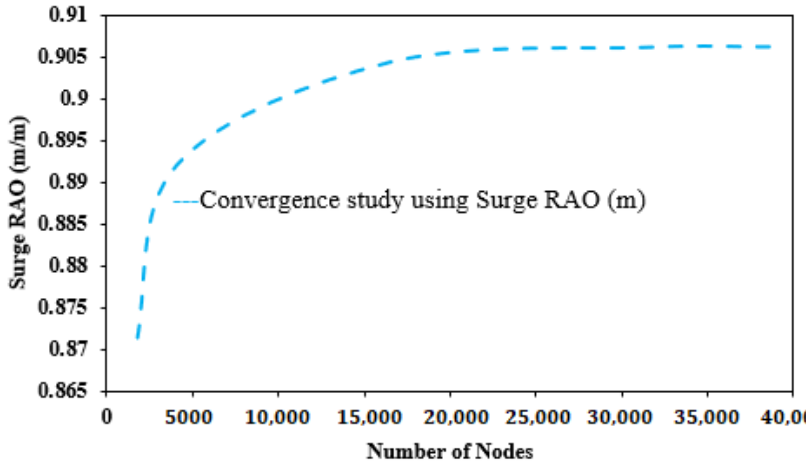
Table 11. Convergence study using surge RAO.